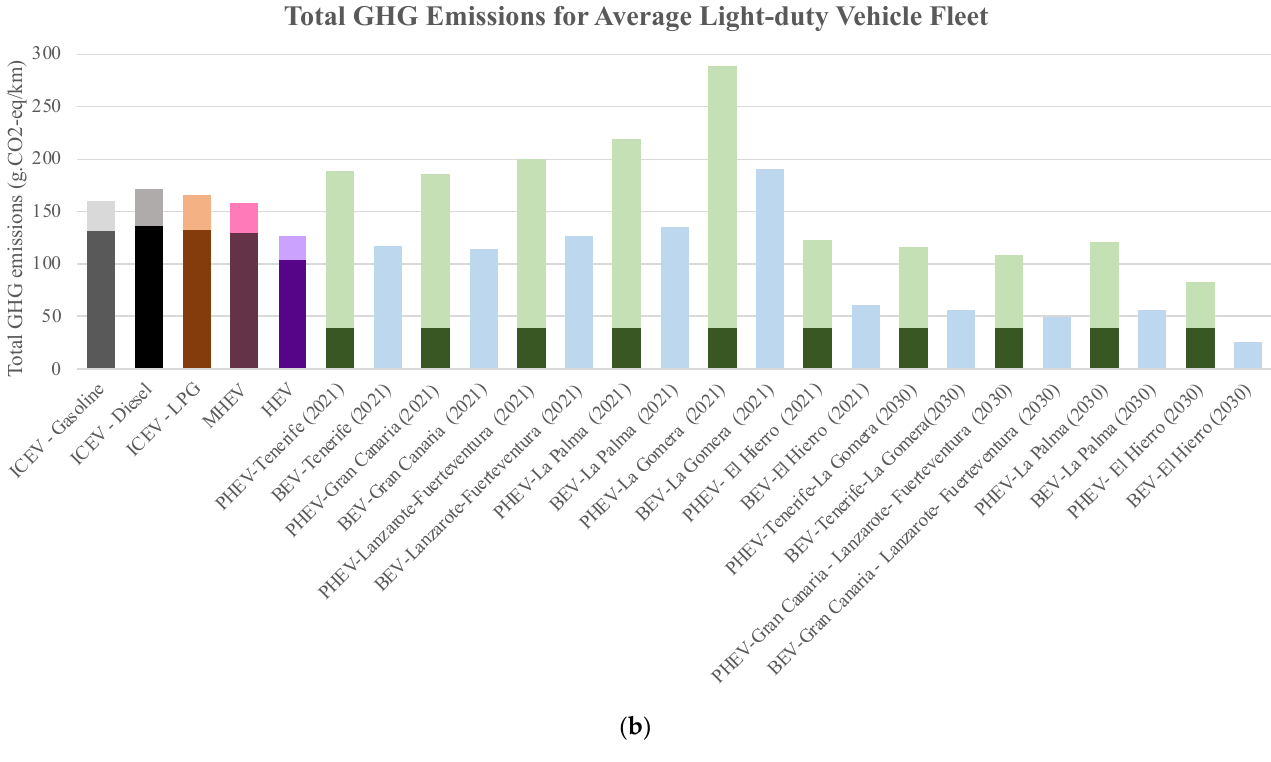
Figure 6. Results of the WtW impacts in the average scenarios for an average vehicle. The darkest portion represents the WtT or WtP impacts and the lightest shows the TtW or PtW impacts: ( a ) energy consumption; ( b ) GHG